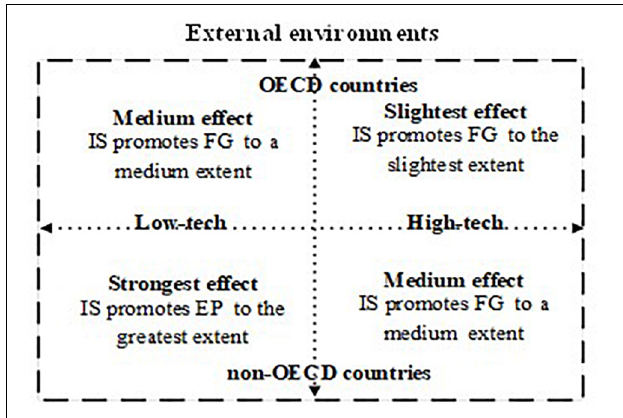
FIGURE 3 | The distribution of the influence of imitation strategy on firm growth. “IS” represents “imitation strategy”; “FG” represents “firm growth.”